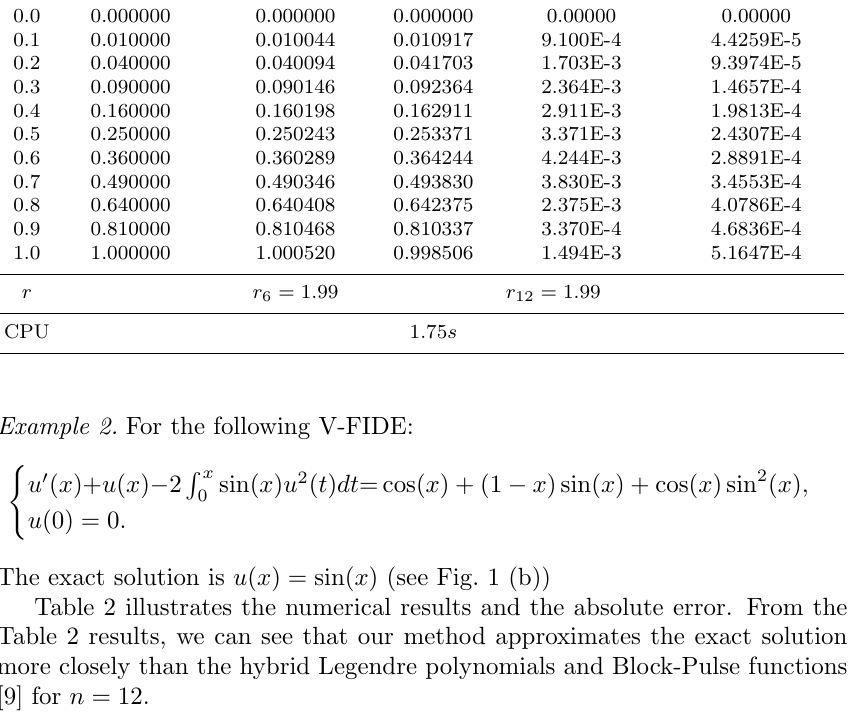
Table 1. Numerical result and absolute error for Example 1. x Exact solution Presented